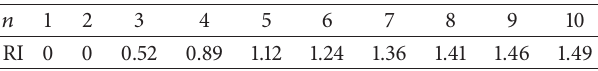
Table 3: Definition of the judgment matrix scale. Table 4: Average random consistency